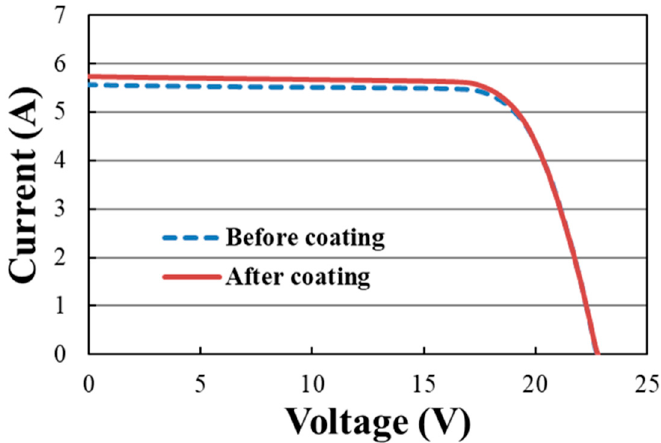
Figure 5. Current–voltage characteristics of module X before and after coating measured using a solar simulator under standard test conditions.